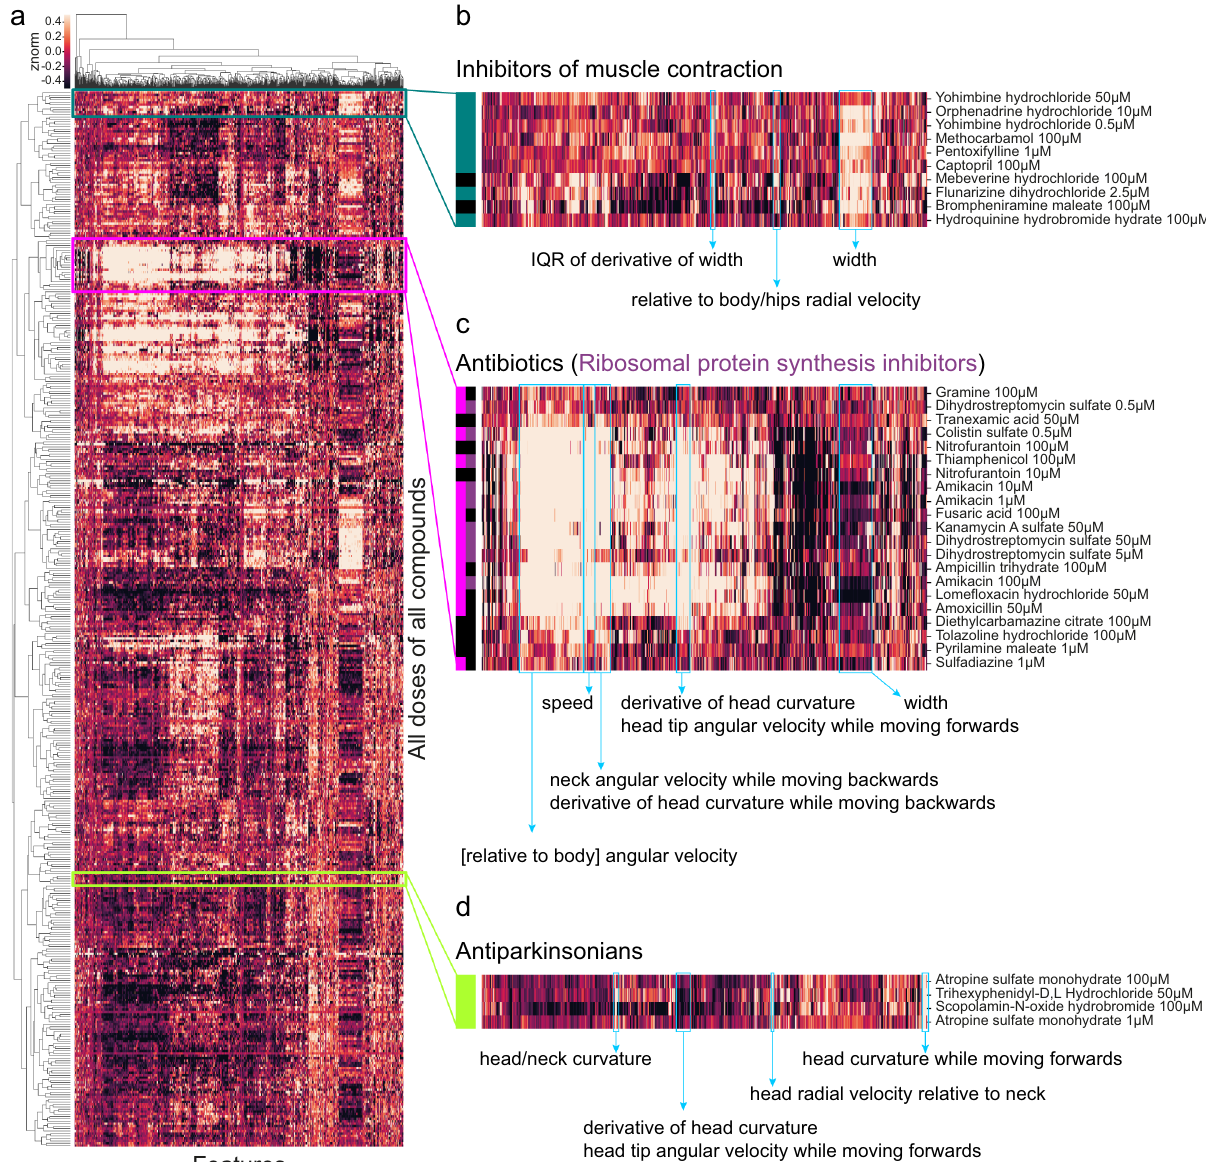
Fig. 5 Worms respond differently to drugs with different modes of action. a Heatmap of behavioural fi ngerprints of worms in response to treatment with drugs. Each row is the average phenotype of worms across multiple wells treated with the same compound at the same dose. Each column is a single behavioural feature. The colour indicates the z-normalised feature value. b – d Some compounds from the same class cluster together according to their behavioural response including inhibitors of muscle contraction ( b ), antibiotics ( c ), and antiparkinsonian (anticholinergic) drugs ( d